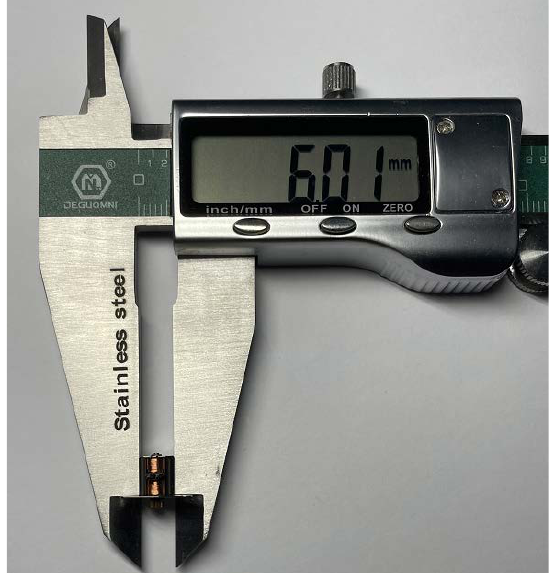
Figure 2. Photo of a 6 mm stepper motor.